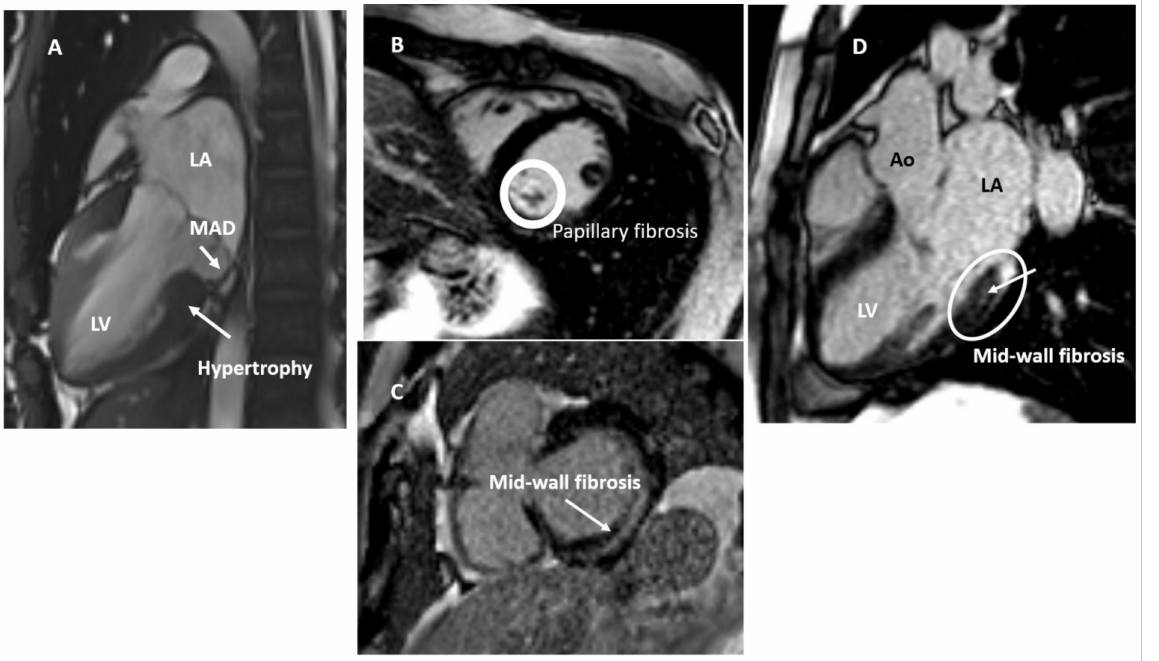
Figure 7. Mitral valve prolapse characteristics on cardiac magnetic resonance. Panel ( A ): basal hypertrophy in mitral valve prolapse with mitral annulus disjunction (MAD). Panel ( B ): papillary muscle fibrosis. Panel ( C ): mid-wall fibrosis (non-ischemic fibrosis). Panel ( D ): mid-wall fibrosis of the basal segment of the infero-lateral wall. Ao, aorta; LA, left atrium; LV, left